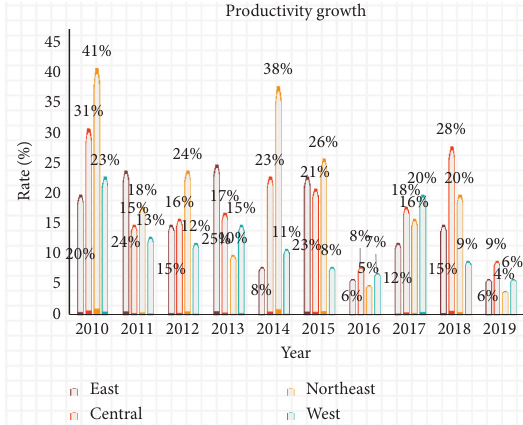
Figure 14: Proportion of cities with total factor productivity growth in each region.